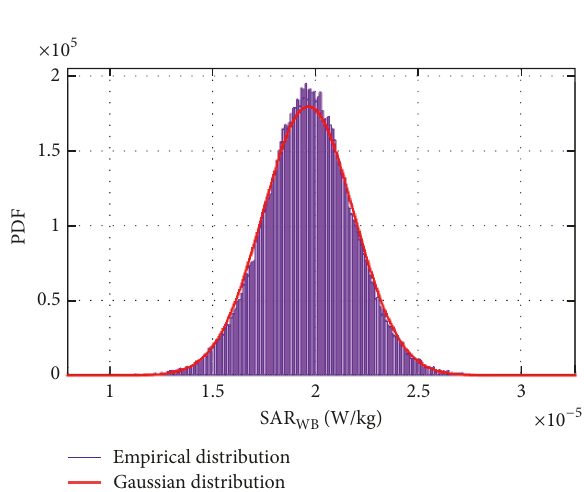
Figure 19: Distribution of the SAR